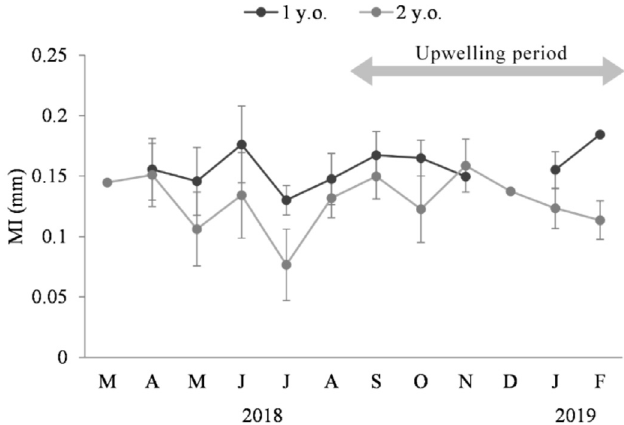
Fig. 4. Monthly means of marginal increment (MI) for 1 year ( ) and 2 years-old ( ) Auxis thazard landed in the Southeastern Brazil between March 2018 and February 2019. Vertical bars denote 95% con fi dence interval.